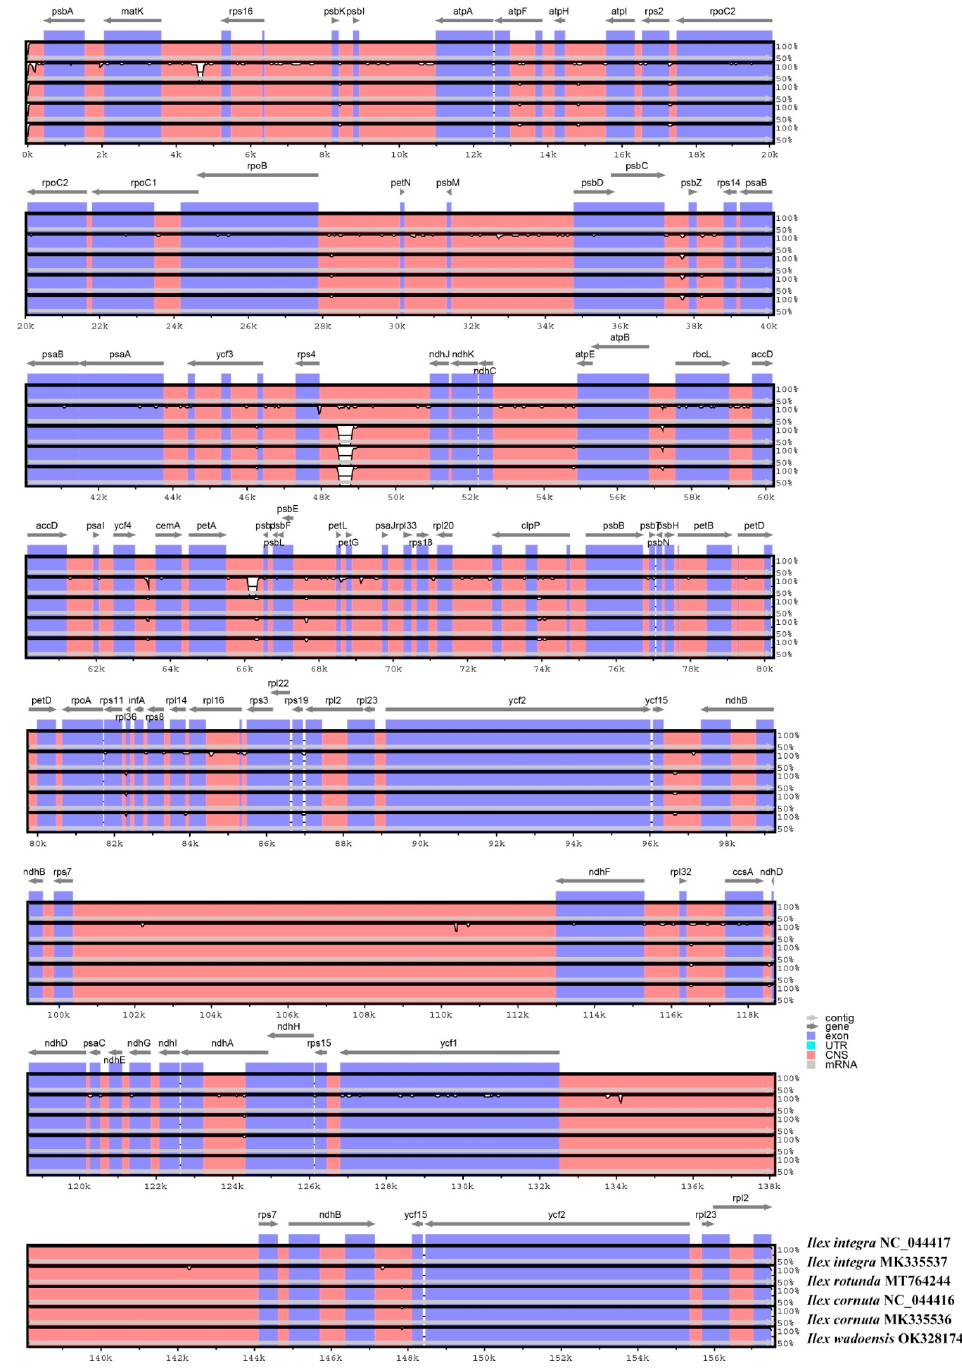
Figure 3. Comparison of the six chloroplast genome sequences using mVISTA. The cp genomes of the four Ilex species were compared with that of I. integra NC_044417. Blue blocks: Conserved genes, red blocks: conserved non-coding sequences. White represents regions with sequence variation among the four Ilex species.